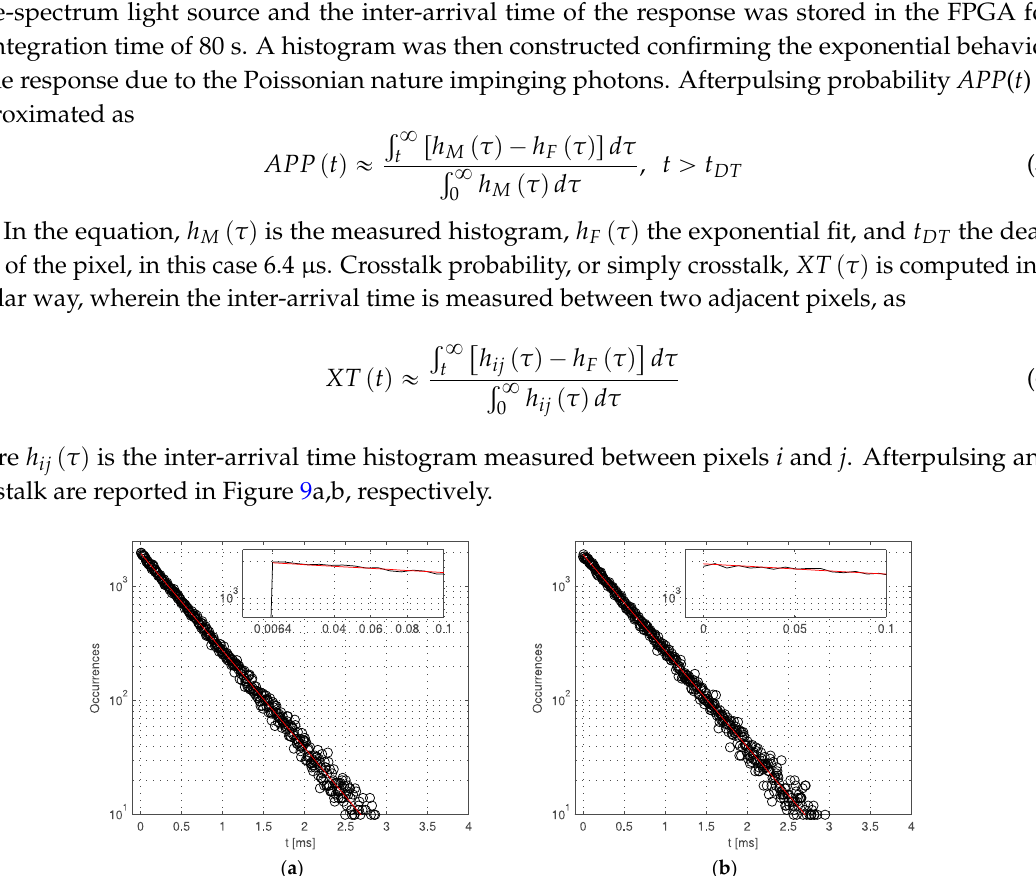
Figure 9. Afterpulsing and crosstalk: ( a ) inter-arrival histogram showing no measurable afterpulsing above the dead time of 6.4 µs, the inset shows a zoom of the plot; ( b ) crosstalk measured using the same method. Note that in this case the dead time is zero, given by the fact that two pixels are independently firing upon detection of a photon [25].